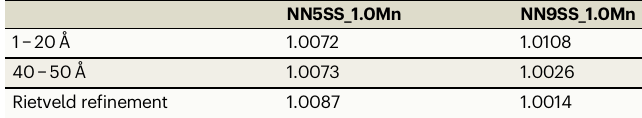
Table 1 | Calculated lattice distortion within the orthorhombic ab plane of NN5SS_1.0Mn and NN9SS_1.0Mn samples, as determined by analysis at different length